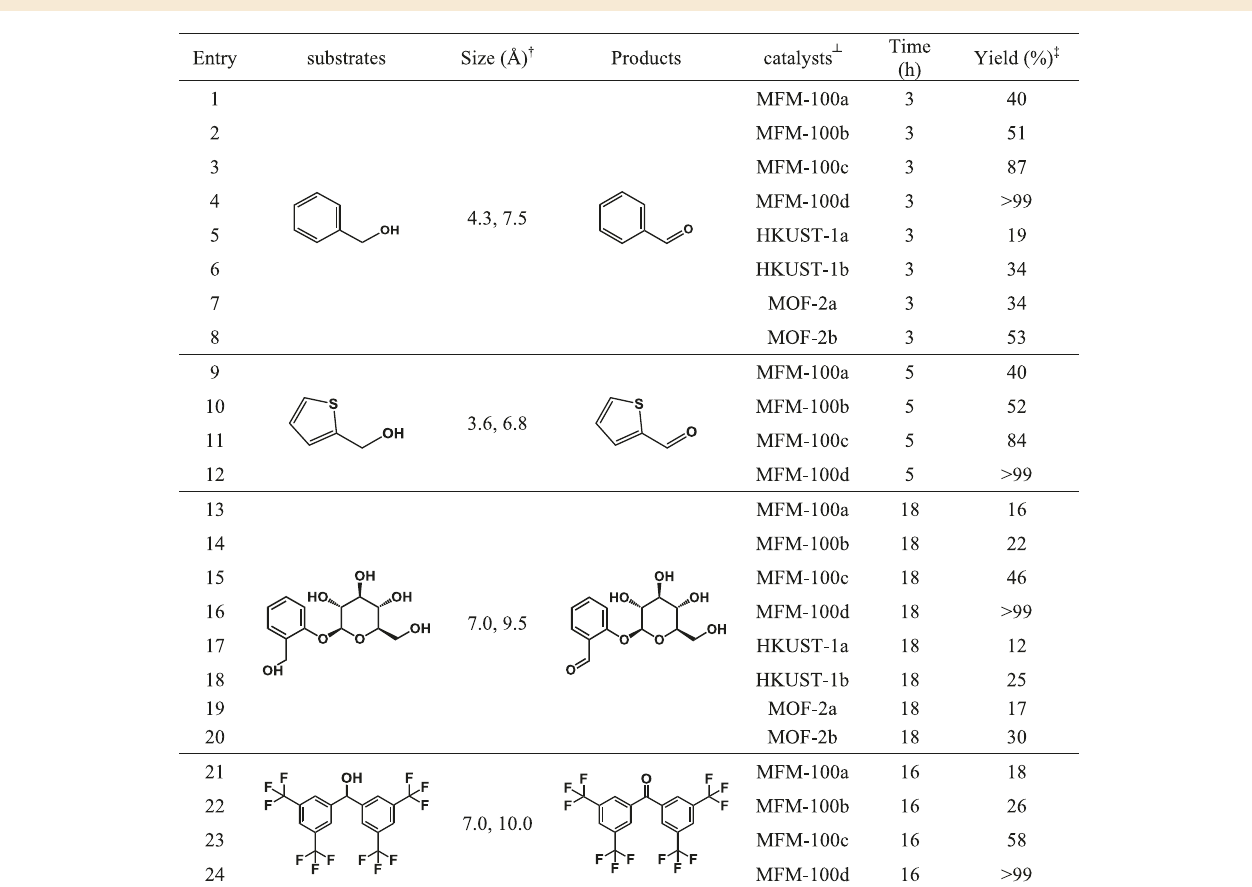
Table 2 Summary of the oxidation of selected alcohols to aldehydes using Cu(II)-MOFs as catalysts